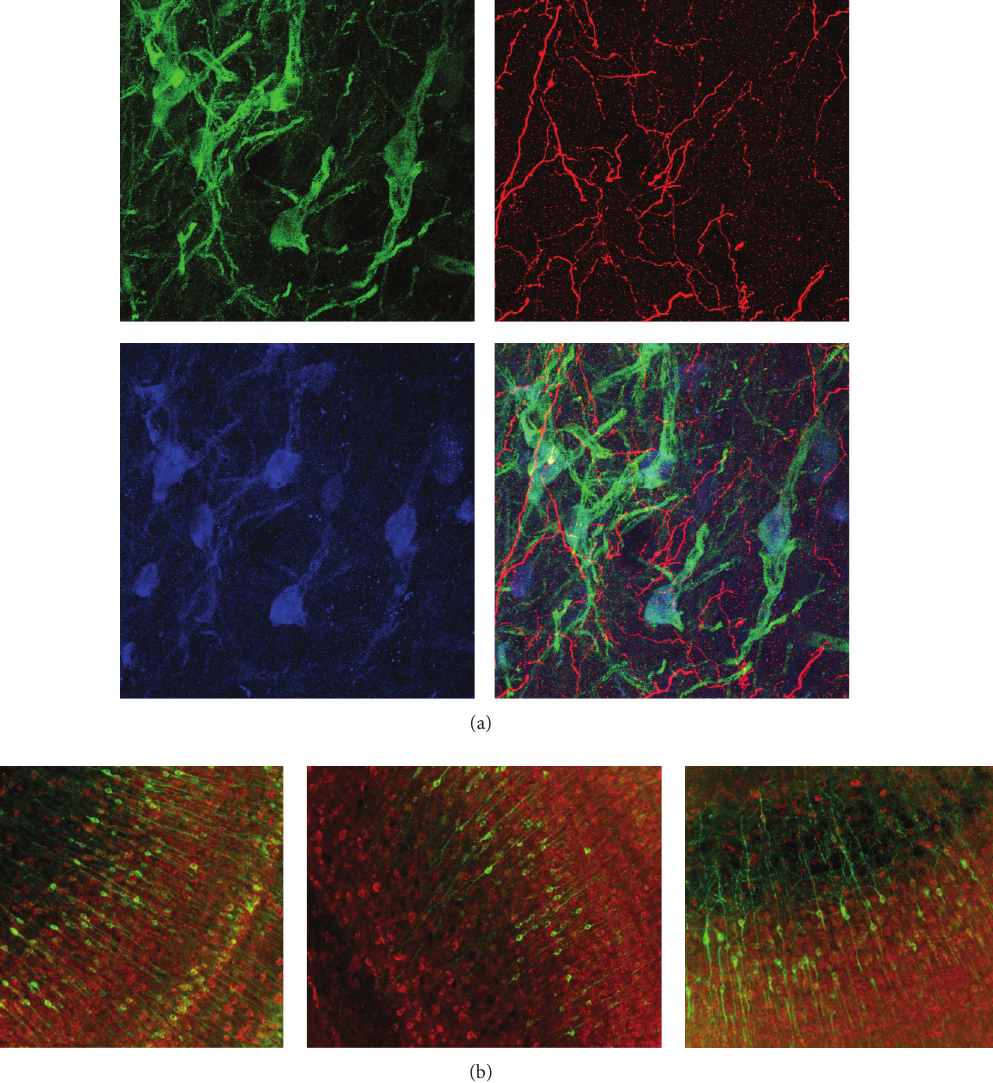
Figure 8: General success of immunohistochemistry in adult tissue. (a) Immunostaining for CaMKII (green), tyrosine hydroxylase (red), DARPP-32 (blue), and overlay (bottom right). (b) Ultrasensitive detection of 𝛼 CaMKII with primary antibody dilution at 1: 5,000 (left), 1: 20,000 (middle), and 1 :100,000 (right). Red channel is EF1 𝛼 at 1:1,000 detected with standard